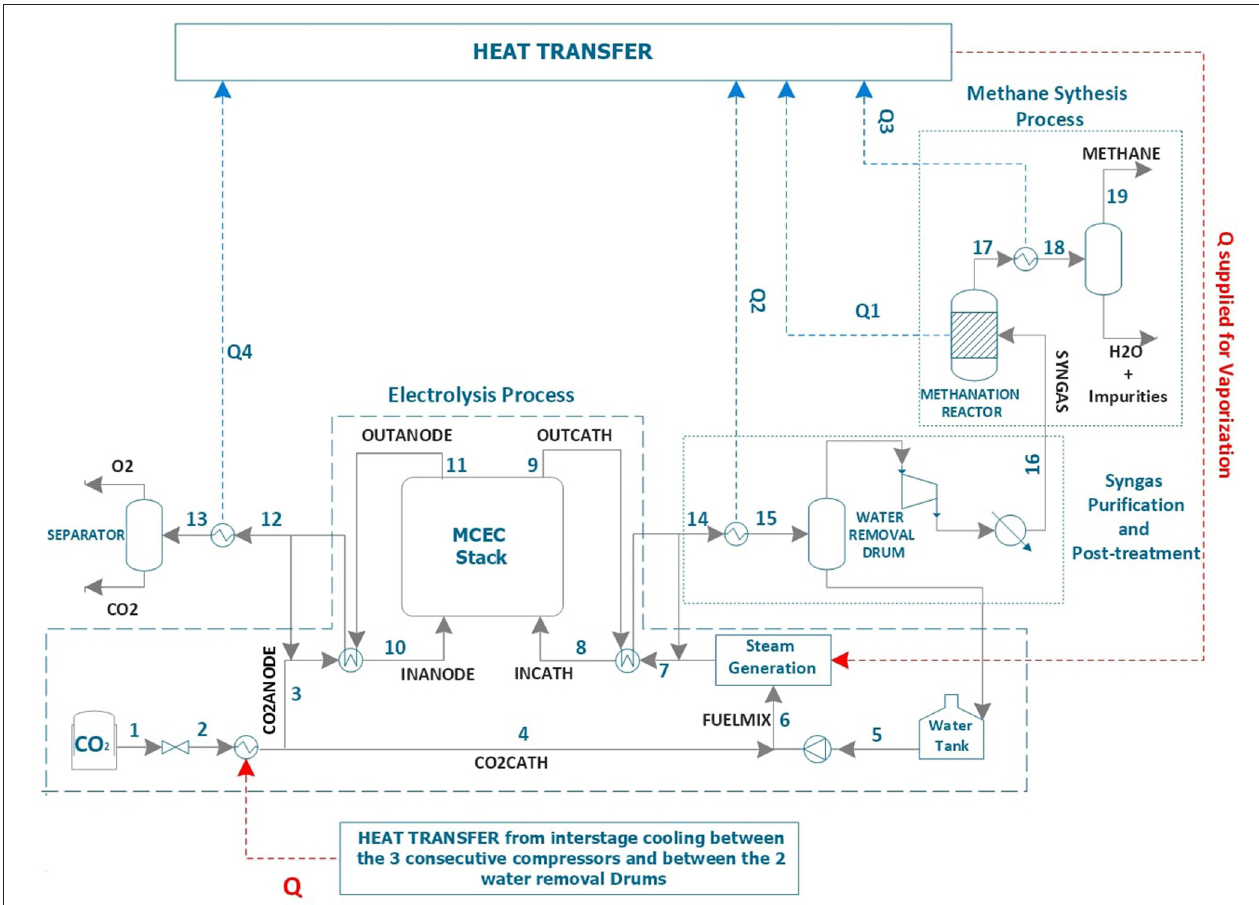
FIGURE 4 | General configuration of the Power-to-Gas (methane) system using MCEC